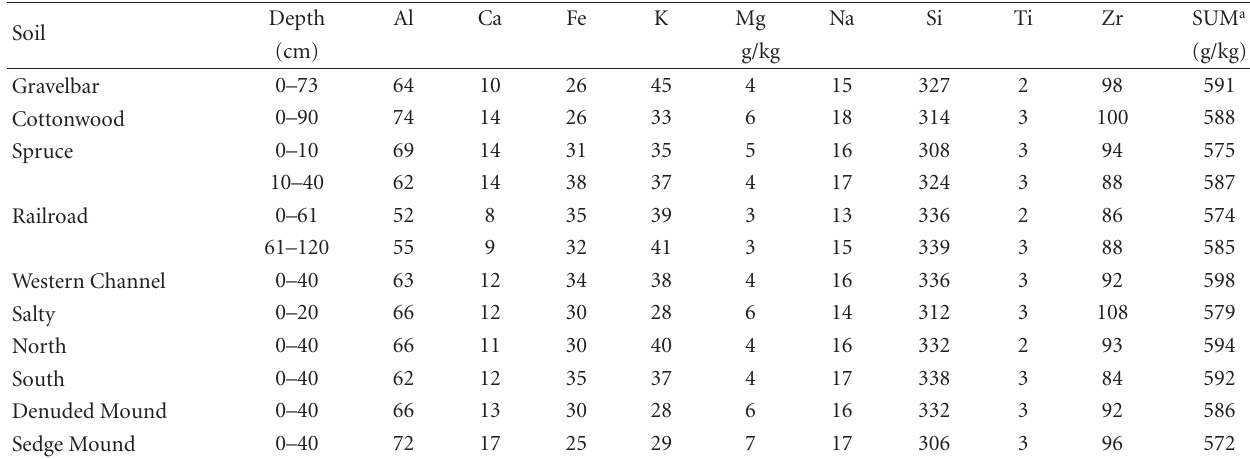
Table 7: Total major element concentrations for study